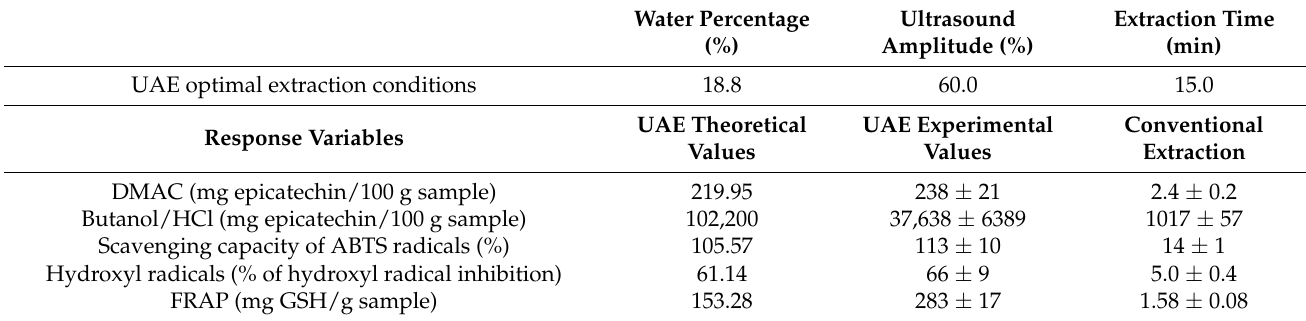
Table 4. Optimal extraction conditions (percentage of water, ultrasound amplitude, and extraction time) to release antioxi- dant NEPs from the extraction residues of mangosteen peels by UAE with ChCl:LA (1:2). Theoretical and experimental values of total PA content (DMAC and butanol/HCl assays) and total antioxidant capacity (scavenging capacity of ABTS radicals, capacity to inhibit the formation of hydroxyl radicals, and FRAP methods) obtained under optimal UAE conditions as well as the results on the extraction of EEPs using a conventional extraction